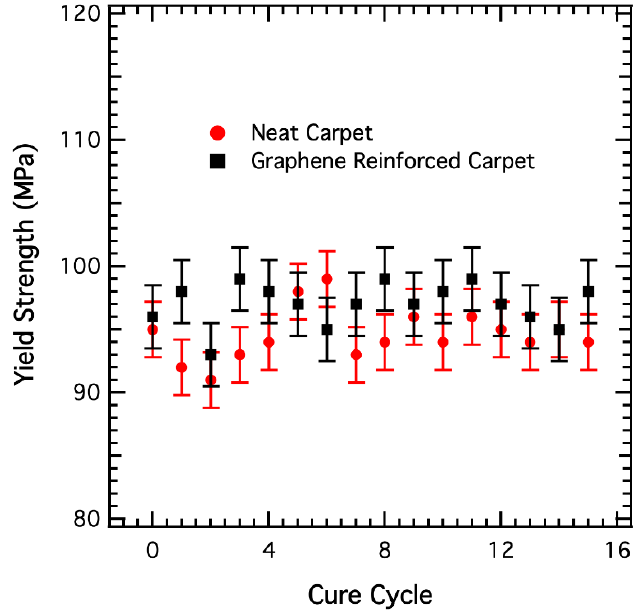
Figure 5. Yield strength values of neat and nanofiller reinforced carpet composite.